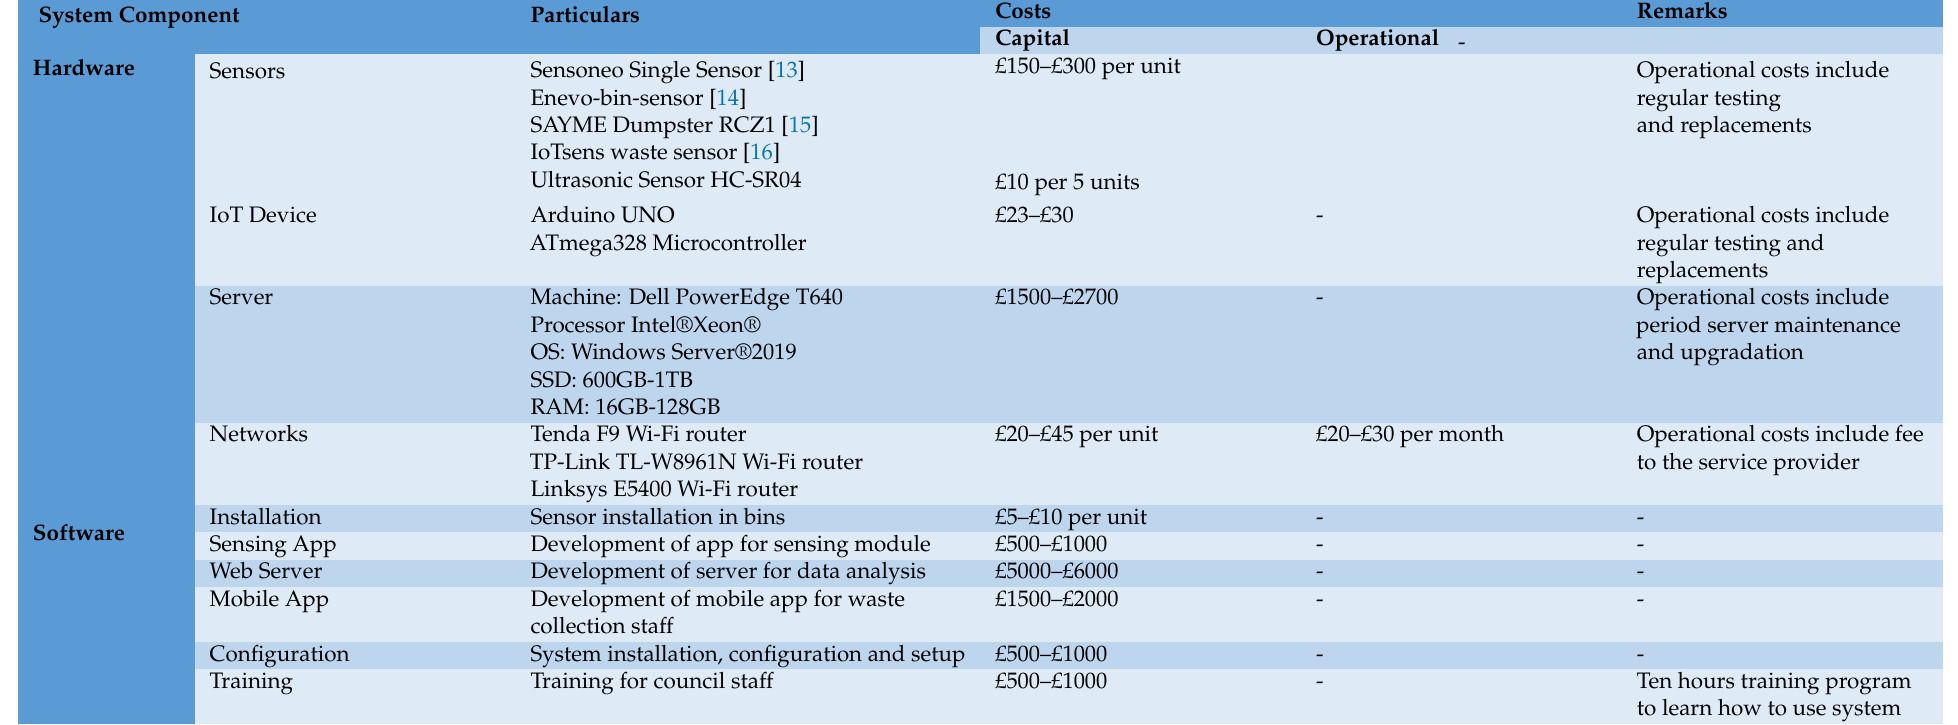
Table 1. Estimated costs of proposed system components—hardware and